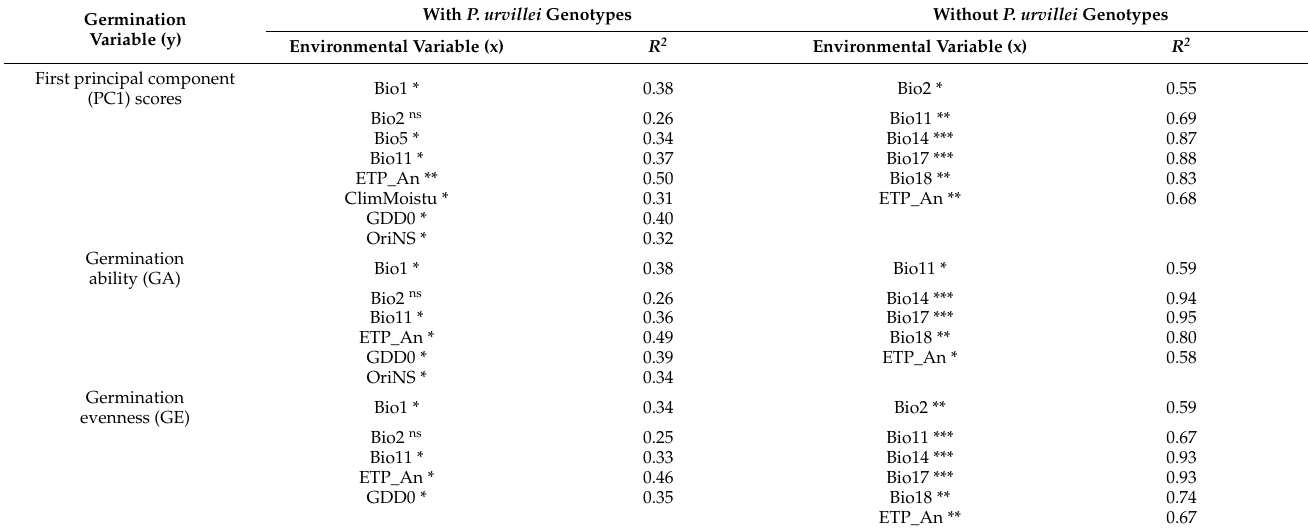
Table A6. Linear regression adjustment ( R 2 ) between each germination variable (PC1, GA and GE) as response and environmental variables with importance in projection higher than one (VIP > 1) after optimizing PLSR as predictors. Results when P. urvillei genotypes are included (left) and when P. urvillei genotypes are not included (right) are shown. High adjustments ( R 2 ≥ 0.80) were highlighted with bold